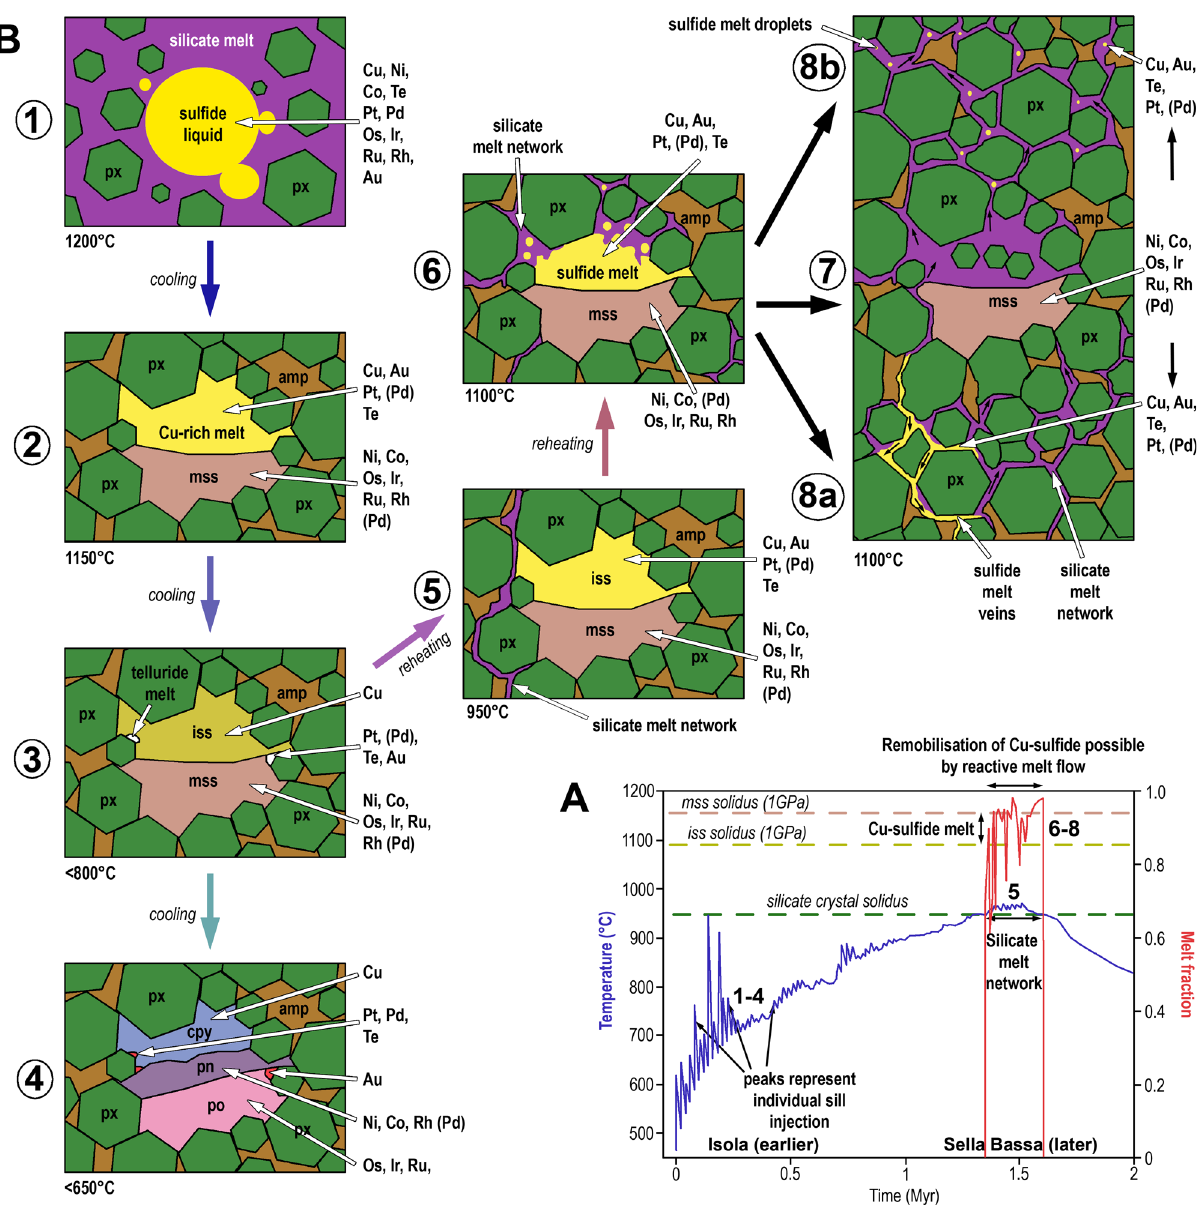
Fig. 6 Proposed scenarios for lower crustal sul fi de crystallization and mobilization. A Modeling results of progressive sill emplacement at the base of the crust in the Ivrea Zone show the rise in overall temperature on the emplacement of successive sills 29 . Approximate relative timings of the Isola Sill and Sella Bassa are shown. Note that each magma pulse is emplaced at 1100 °C, though cools quickly; and a signi fi cant melt fraction only becomes present when the overall temperature of the complex reaches the silicate solidus. At 1 GPa, Cu-sul fi de melt is present and mss crystalline between 1090 and 1160 °C. B Schematic representation of the evolution, fractionation, and mobility of sul fi de liquid in lower crustal cumulates. See text for description of Steps 1 – 8. px pyroxene, amp amphibole, mss monosul fi de solid solution, iss intermediate solid solution, cpy chalcopyrite, pn pentlandite, po